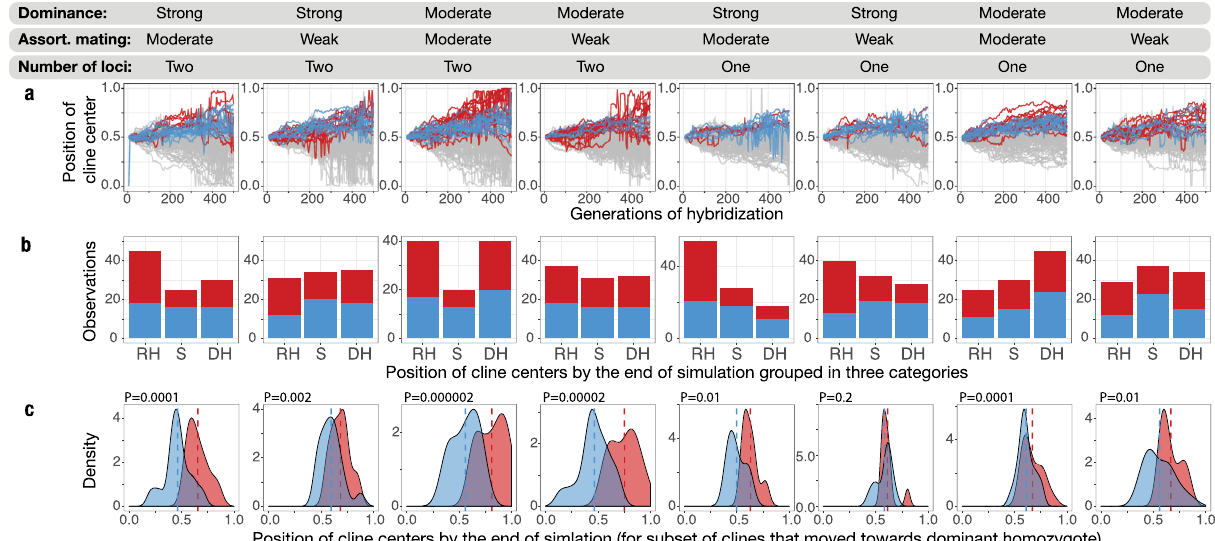
Fig. 4 Simulations of temporal dynamics of hybridization where alleles for a reproductive barrier trait have partially dominant expression in one population, and with incomplete assortative mating. Throughout the fi gure, red and blue colors indicate mating trait and selectively neutral clines, respectively. a Position of cline centers ( Y axis) over a course of 500 generations of hybridization ( X axis). The eight scenarios vary in the strength of assortative mating, degree of partial dominance and a number of loci underlying mating trait. All clines have centers initially positioned at 0.5 and are allowed to move towards a trait encoded by recessive homozygote (0) or dominant homozygote (1). Clines moving towards dominant homozygote in mating trait and selectively neutral loci are highlighted. b Frequency of cline centers displaced towards recessive homozygote (RH, 0 – 0.44), staying relatively stable in space (S, 0.45 – 0.55) and displaced towards dominant homozygote (DH, 0.56 – 1) by the end of the simulation. c Distribution of cline center positions for selectively neutral and mating trait loci for a subset of mating clines moved towards dominant homozygote (DH). Mean centers are indicated by dashed lines. P -values stand for paired one-sided Wilcoxon test. Note that under the tested parameter combinations, the mating cline will rarely stay stable in space and will be moving towards recessive or dominant homozygote genotype. The latter scenario, matching the pattern observed in the wagtail hybrid zone, was an especially likely outcome under the moderate partial dominance and moderate assortative